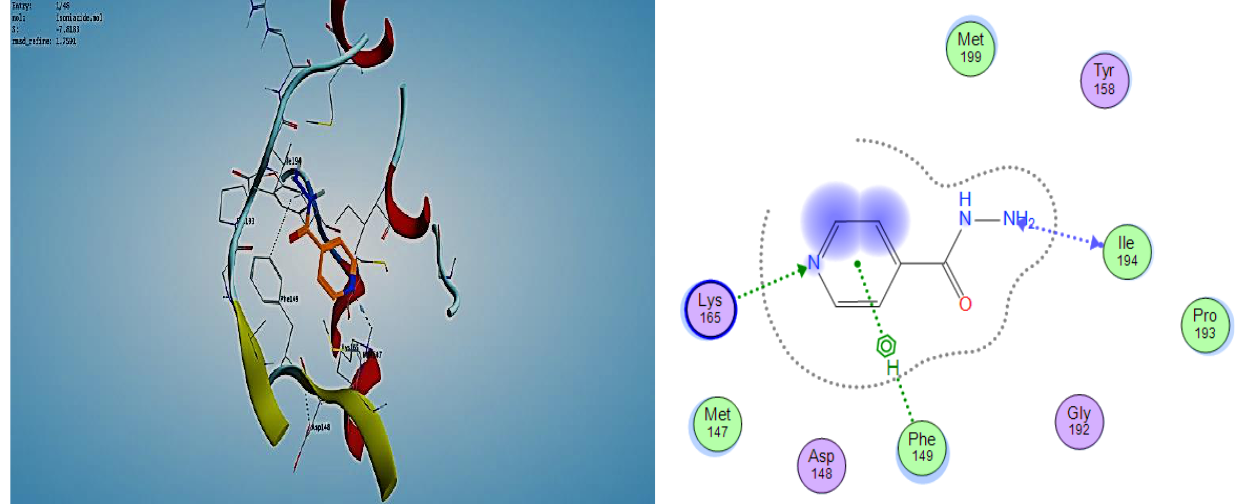
Figure 13. Docking and binding pattern of Isoniazide into inhA active site (PDB ID: 4TRO) in 2D (right panel) and 3D (left panel).